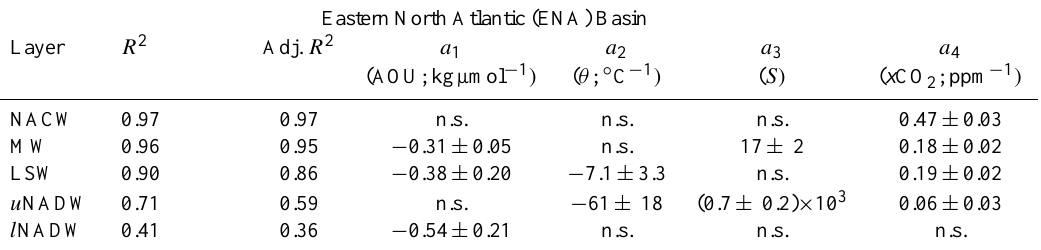
Table A1. List of coefficients obtained for Eq. (A6) using the expression given in (A7) for each layer in the ENA basin. The constant terms “ k ” are not input parameters in (A6) and not reported. The information between brackets in the header line gives the associated “ i − th” property and the units of the “ a i ” coefficients. The “n.s.” acronym stands for “not significant”. The variables with this acronym explained very little of the C ENA ,l,c ant variability and worsened the overall MLR fit. They were, therefore, rejected according to a stepwise method of MLR